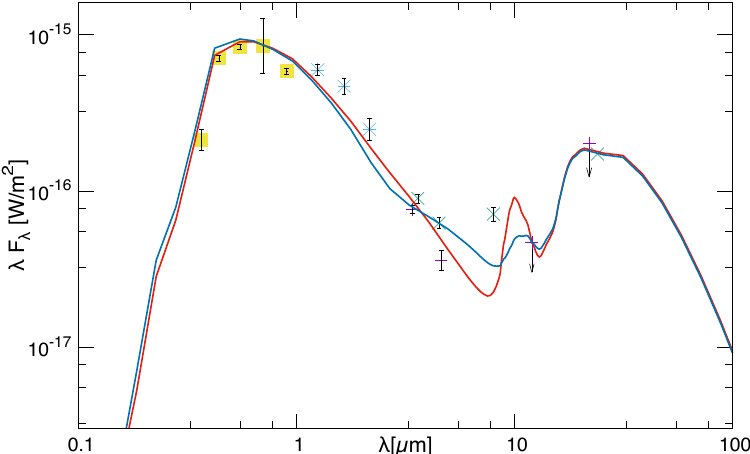
Figure 3. Observed spectral-energy-distribution of the post-RGB object, J043919.30-685733.4 and preliminary models. The observed fluxes are de-reddened for Galactic and LMC reddening. Curves show two preliminary “best-fit” two-component model fits using “warm” (Sil-Ow) silicate dust (optical constants from [45]). Each model includes an extended shell and a compact disk component, the former (latter) mainly constrained by the SED in the > ∼ 10 µ m ( < ∼ 10 µ m) range. The shell/disk mass ratio in Model 1 is higher than that in Model 2 by a large factor ( > ∼ 10). In Model 2 the disk has large grains ( a min ∼ 1 µ m, a max ∼ 25 µ m), whereas the shell has standard MRN (i.e., small) grains. In Model 1, both the shell and the disk have standard MRN grains. The main discrepancies in the fits provided by these models are in the ∼ 5–12 µ m region, which may be due to the presence or lack of dust-spectral features (e.g., presence of PAH (Polycyclic Aromatic Hydrocarbons) emission in model 1, lack of silicate emission in Model 2) (adapted from Sarkar & Sahai 2020, in preparation: SS20)—MIRI spectroscopy in the 5–28 µ m region is needed to determine if dust features affect the broad-band photometry and better constrain the